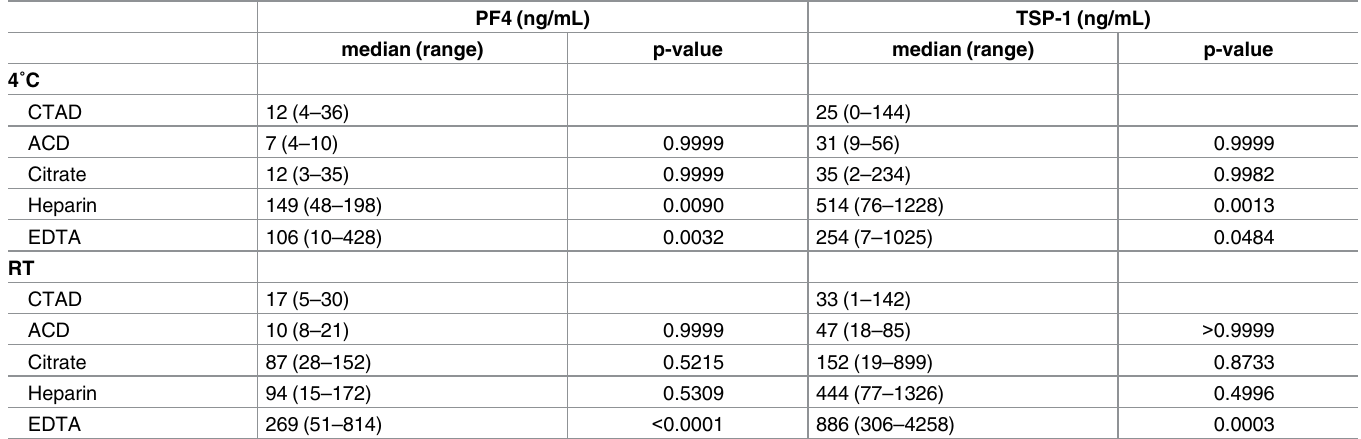
Additionally, this effect increased even more after 2 hours and 6 hours in heparin and EDTA plasma. Citrate plasma showed comparable levels of PF4 and TSP-1 with CTAD plasma when processed at 4˚C, however, after a time period of 24 hours the levels were increased 23-fold and 20-fold in comparison to optimized CTAD plasma preparation, respectively.